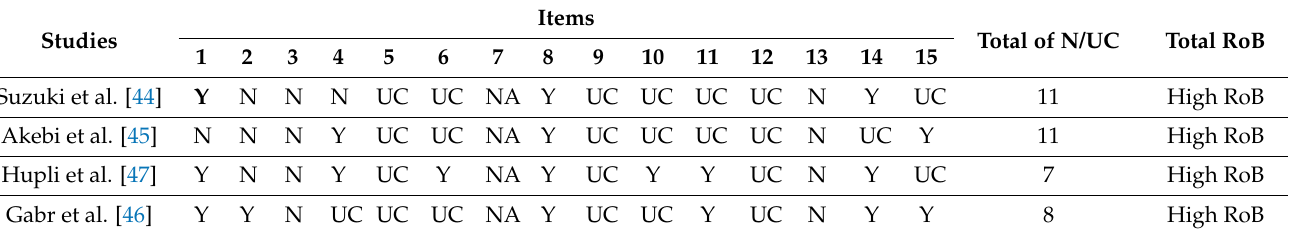
Table 2. Methodological quality of the studies